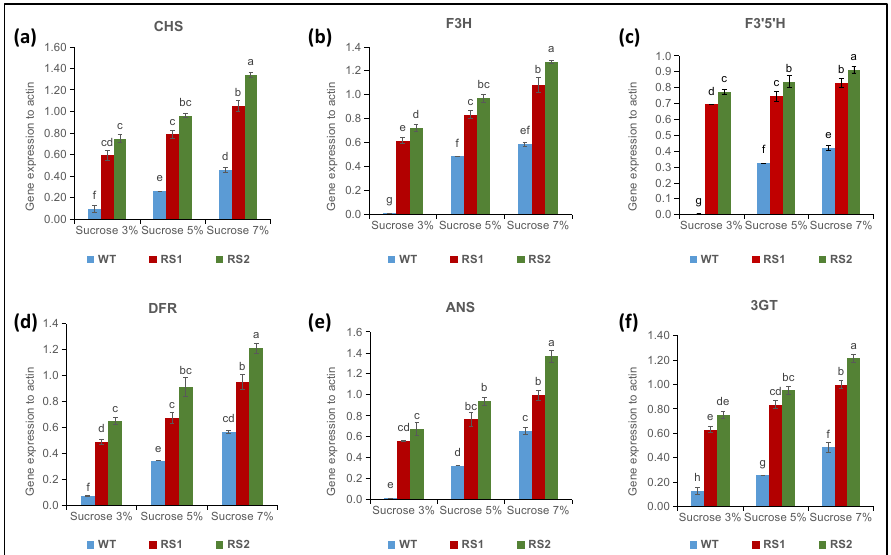
Figure 2. Effect of sucrose on anthocyanin biosynthesis gene expression levels ( a – f ) in wild type (WT) plants and transgenic lines overexpressing RsMYB1 . Data are presented as the means of three replicates. Error bars indicate standard error. Groups annotated with the same letter are not significantly different by Duncan Multiple Range Test (DMRT, p < 0.05).